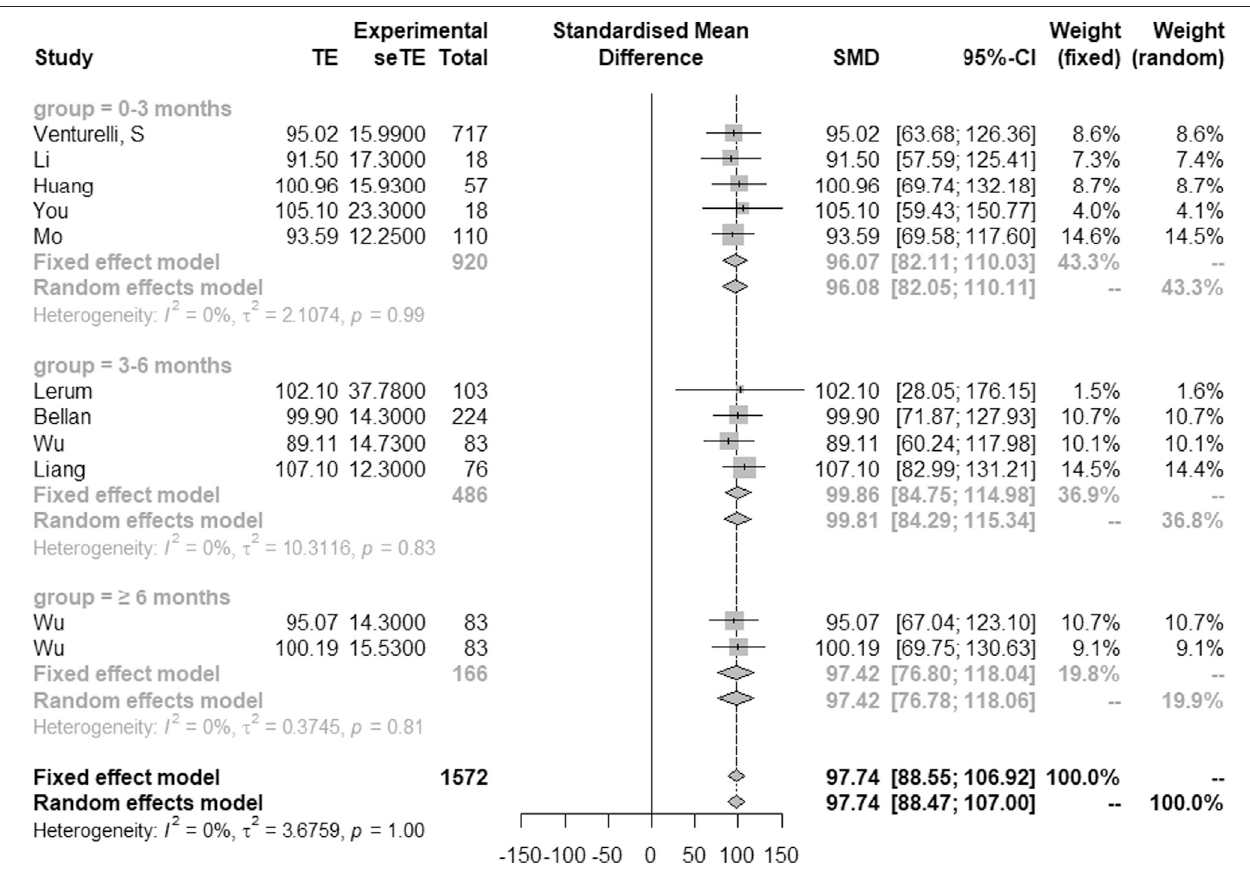
FIGURE 3 | Comparison of longitudinal changes in FVC (% of predicted). Forest plot showing meta-analysis of FVC (% of predicted).